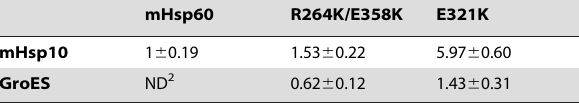
Table 2. SPR analysis.